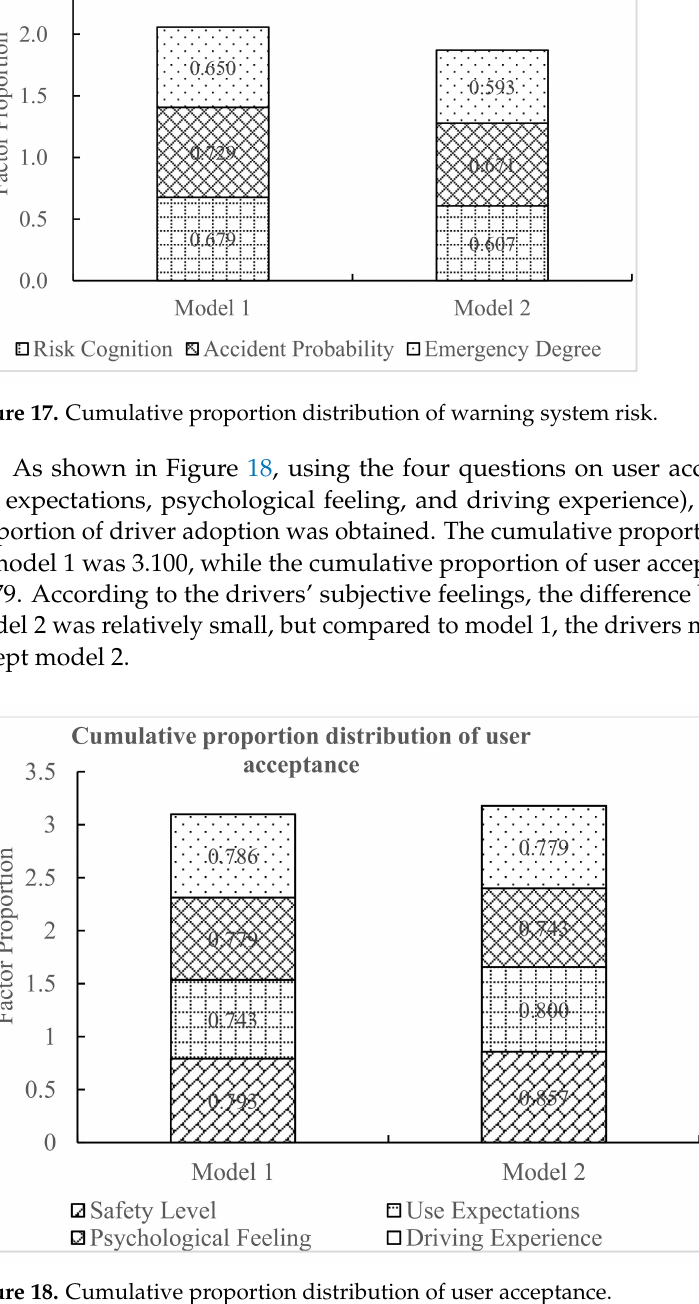
Figure 18. Cumulative proportion distribution of user